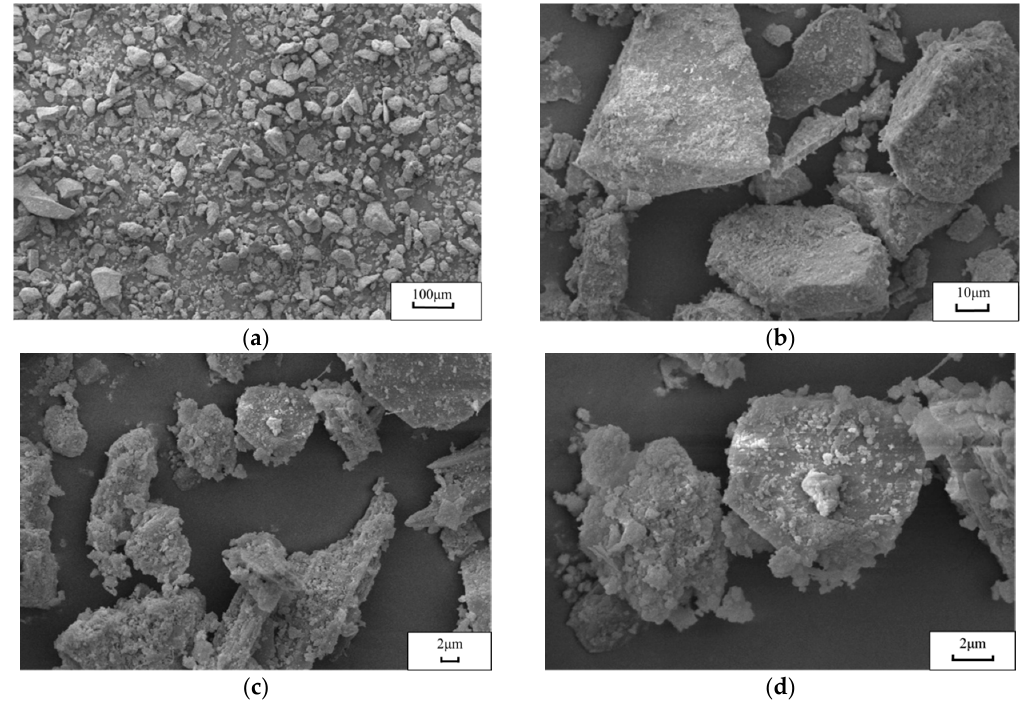
Figure 6. The scanning electron microscope images of the CRFA powder. ( a ) 100×, ( b ) 800×, ( c ) 2000×, ( d ) 5000×. Materials 2020 , 13 , x FOR PEER REVIEW 12 of 16